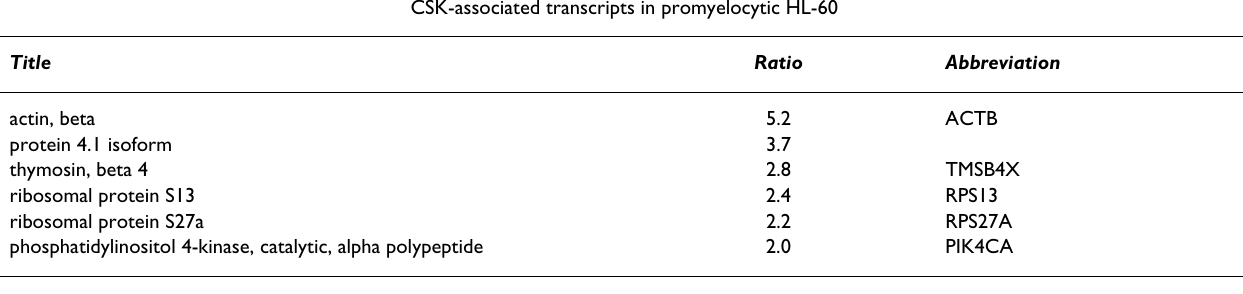
Table 1: Cytoskeleton-associated mRNAs identified in HL-60